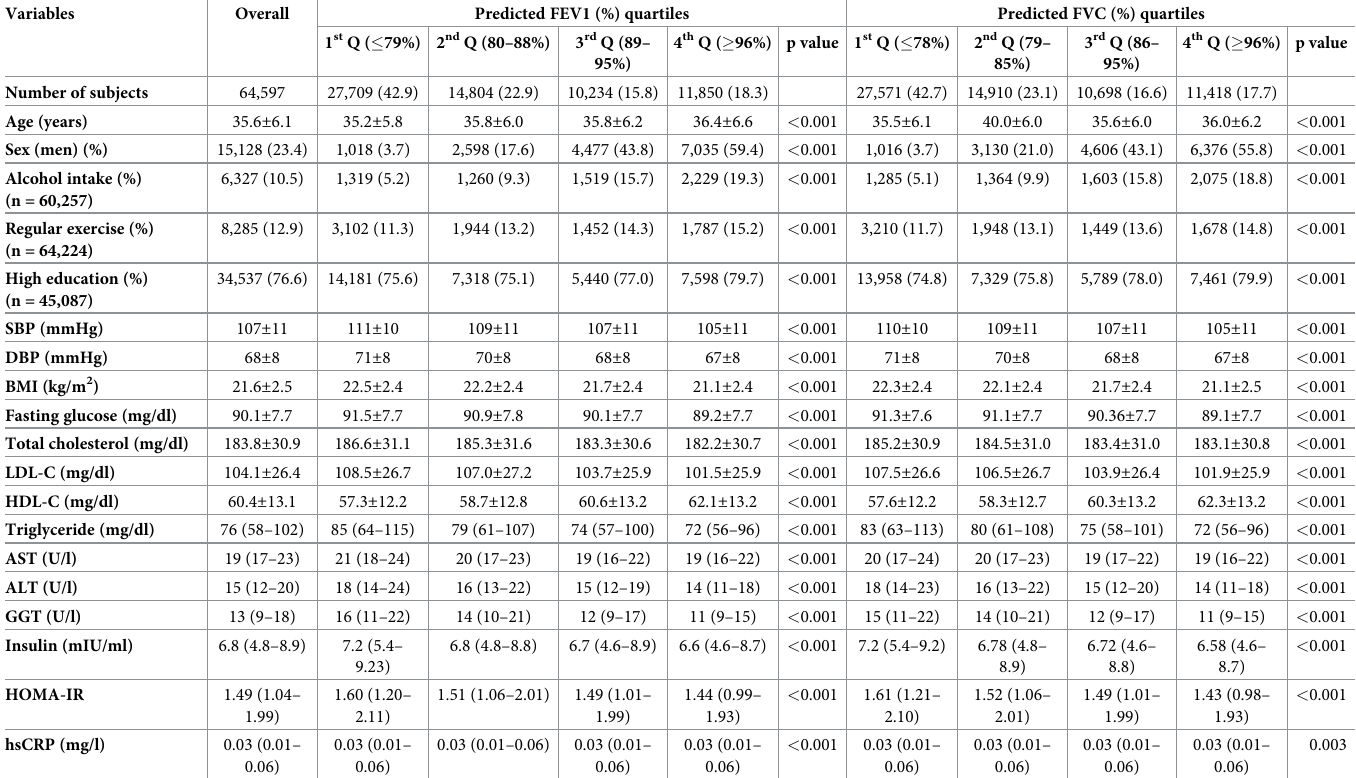
Table 3. Comparisons between Four Groups according to Initial Spirometric values in never smokers without NAFLD at baseline. Variables